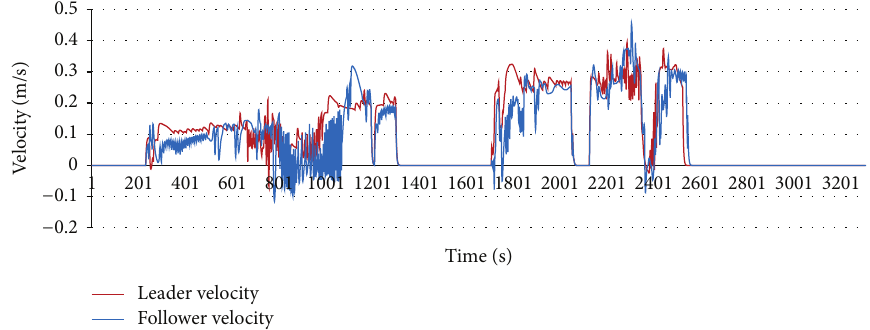
Figure 6: Simulation result of the Kinect sensor application.